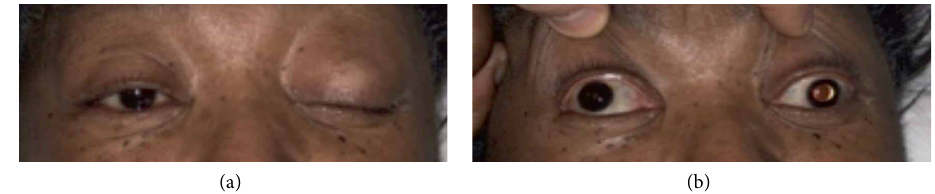
Figure 1: (a) The patient was asked to open both eyes. (b) Both upper eyelids were passively opened. There is a clear anisocoria with down and outward left gaze